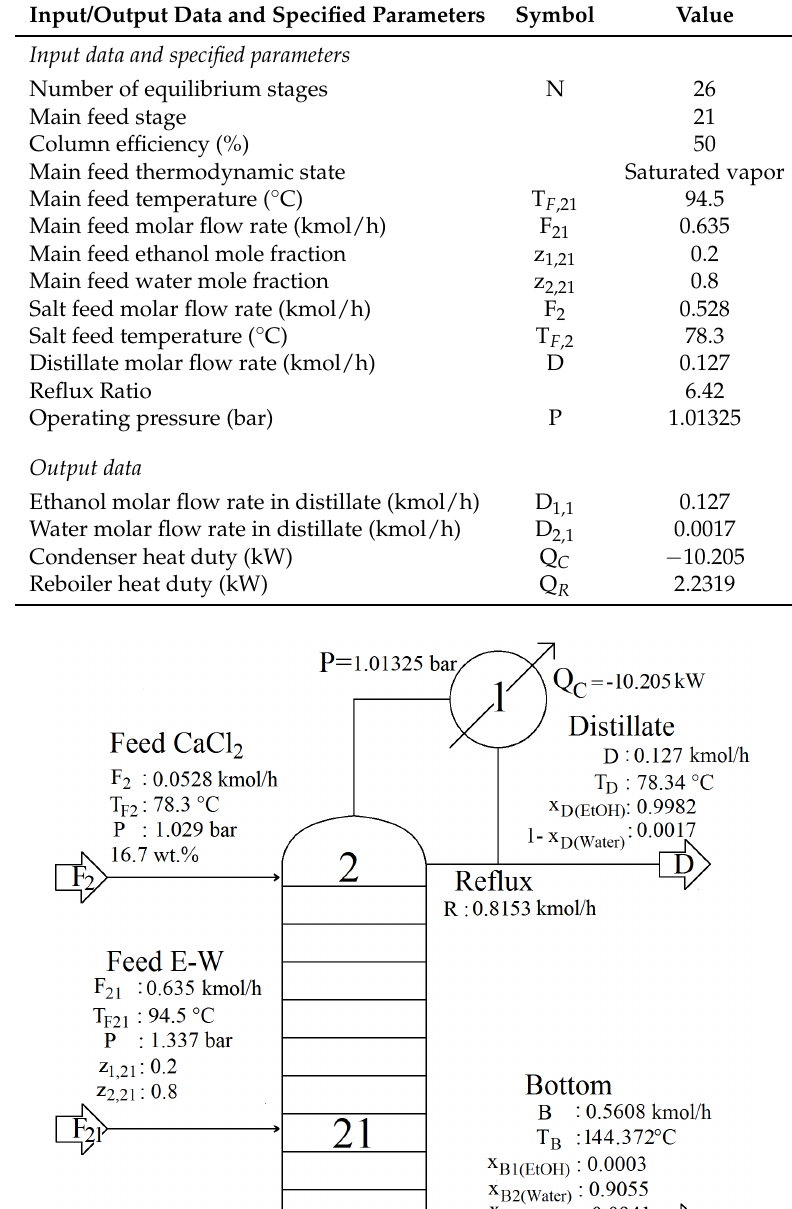
Table 3. Input data, specified parameters, and overall output data for the simulation of the saline extractive distillation column with CaCl 2 as separating agent.